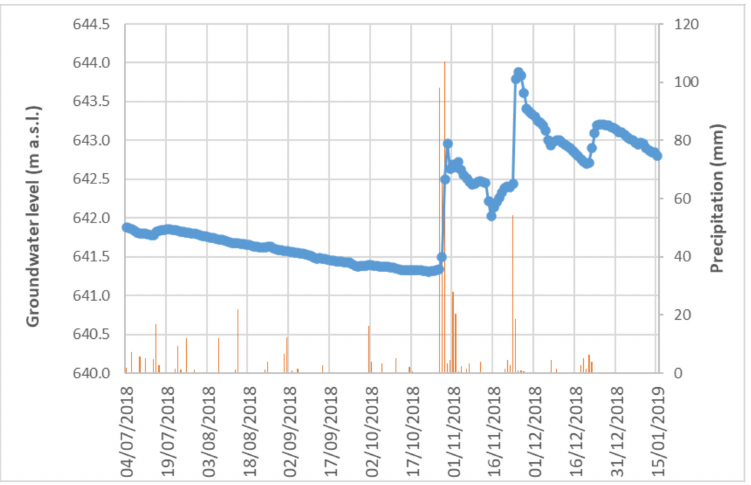
Figure 2. Groundwater level fluctuations vs rainfall in piezometer P1.